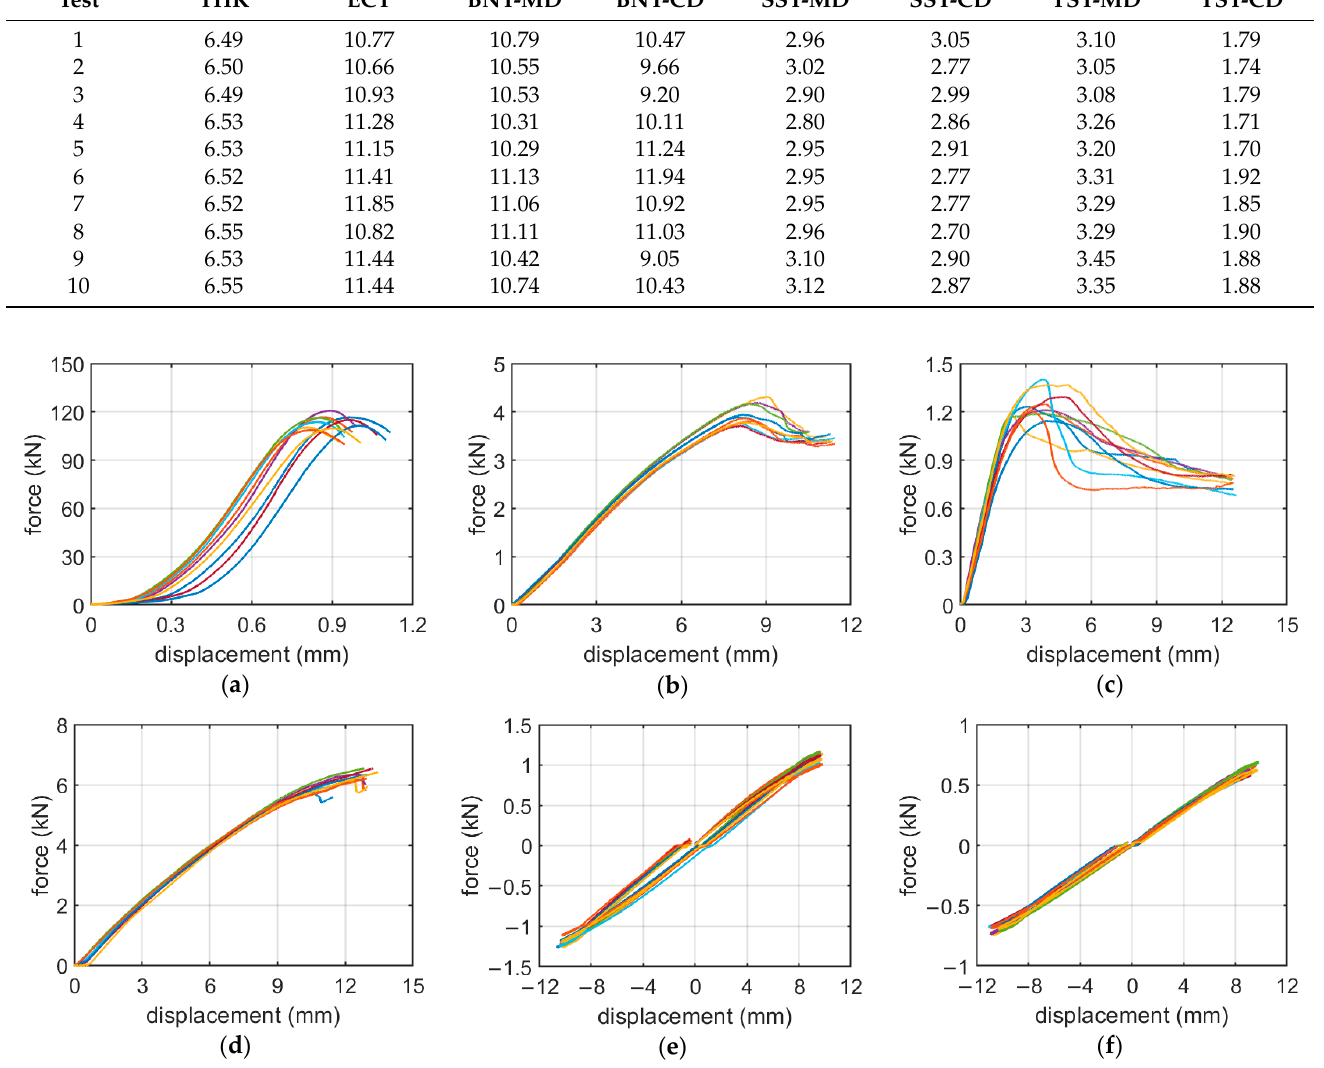
Table 1. Test values for BC-780 corrugated cardboard grade. Table 2. Test values for corrugated cardboard grades.